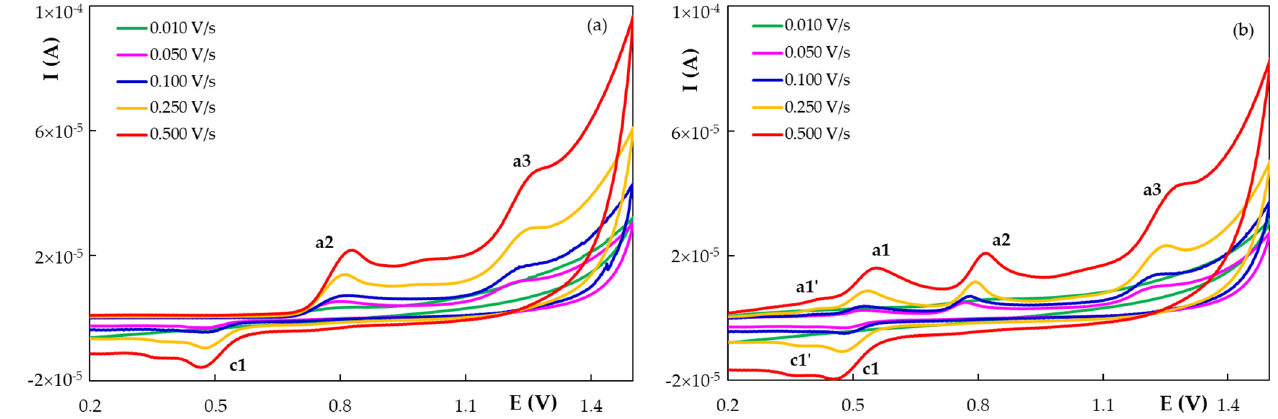
Figure 5. Selected cyclic voltammograms recorded with different scan rates at H type PGE for 1.00 × 10 − 4 mol/L HESP in BRB solution pH 1.81 ( a ) first potential scan and ( b ) second potential scan.